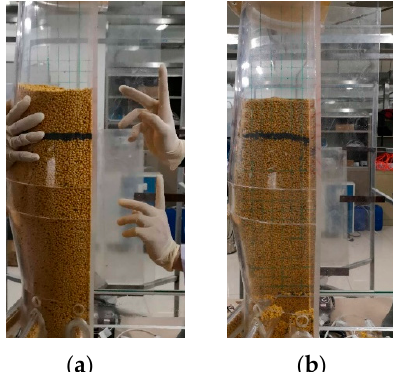
Figure A3. The cutting method in experiment. ( a ) The process of the cutting method; ( b ) the internal